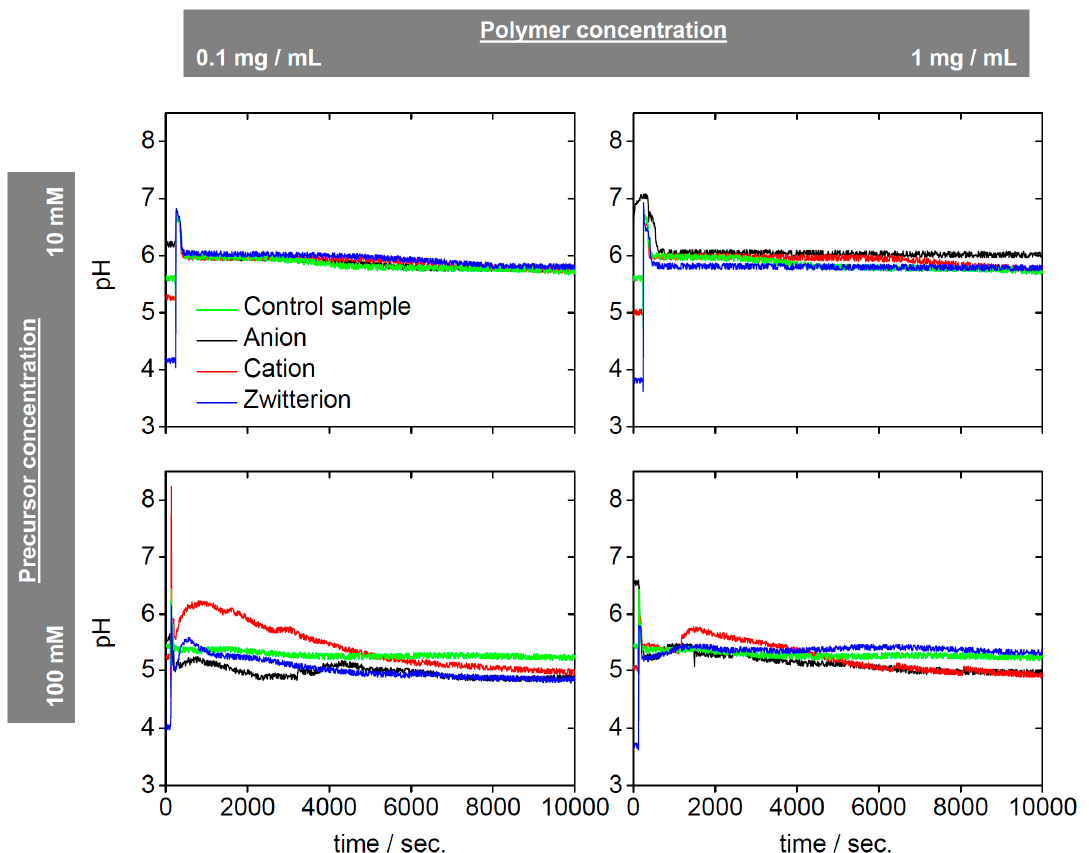
Figure 7. Representative pH curves recorded during the mineralization reaction vs. polymer chemistry, polymer concentration, and precursor concentration.